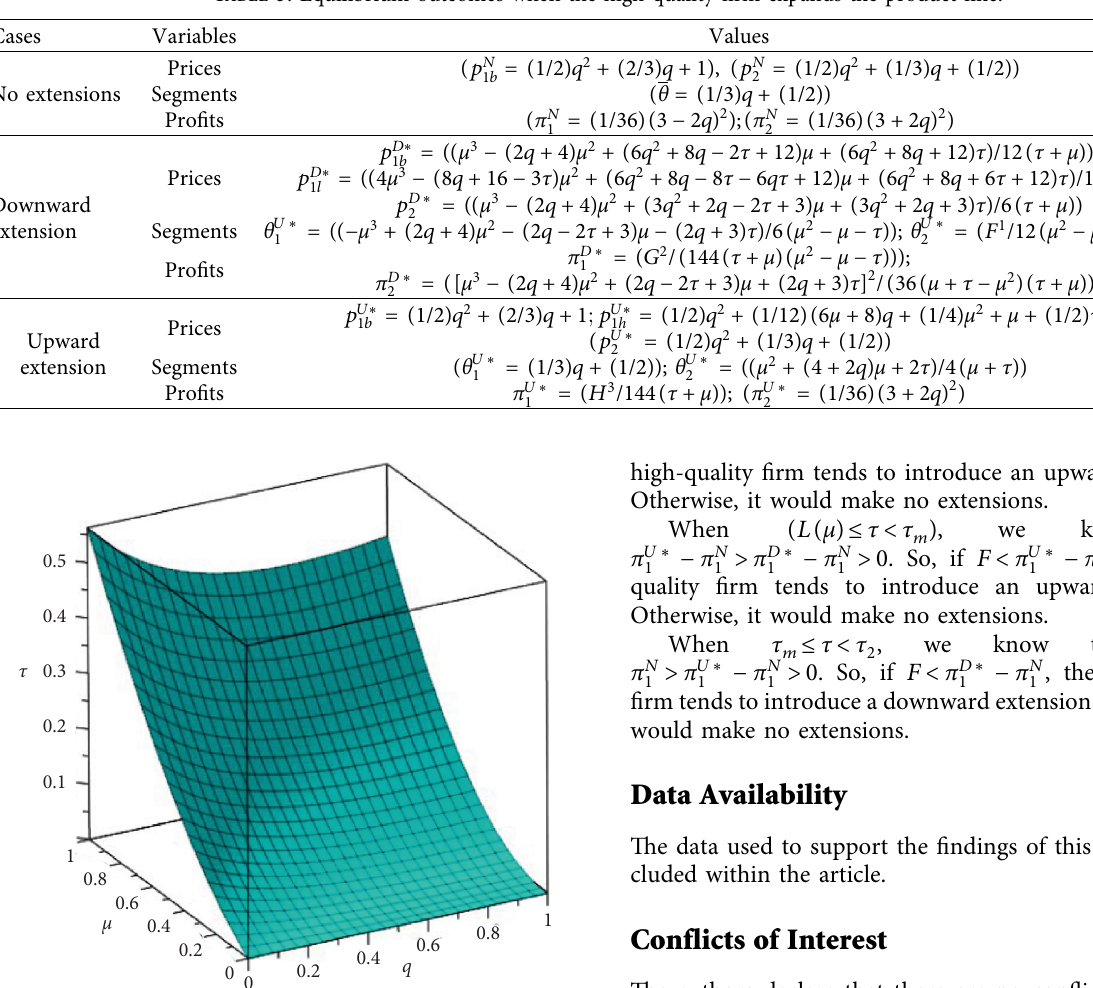
Table 3: Equilibrium outcomes when the high-quality firm expands the product line.